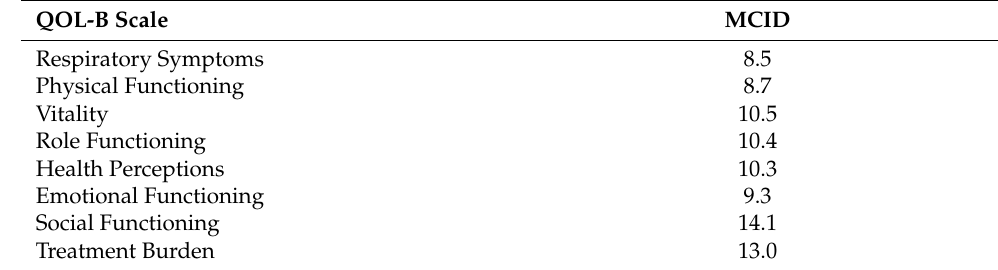
Table 7. MCID estimates for the QOL-B